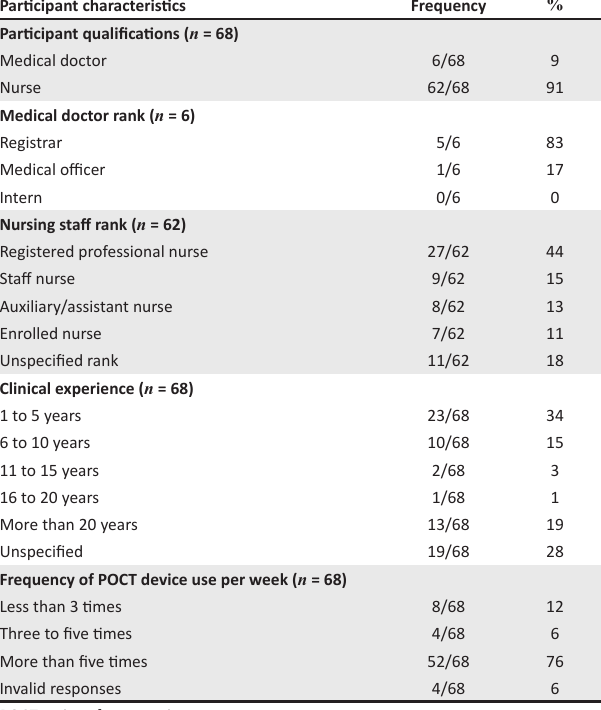
TABLE 1: Participant characteristics, ranks and clinical experience of Tygerberg Hospital, Cape Town South Africa,